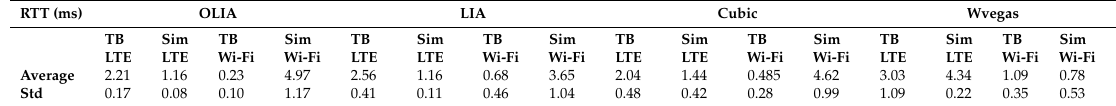
Figure 13. Setup 2 uplink MPTCP RTT for 20 MB flows. Table 5. Setup 2 uplink RTT for 20 MB